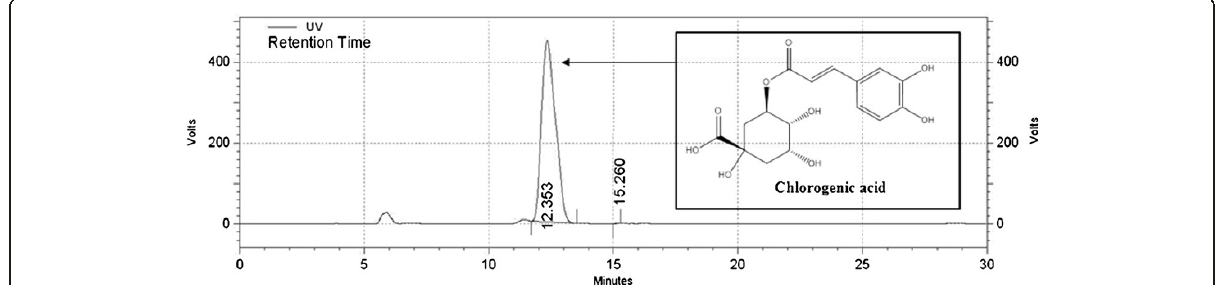
Figure 1 HPLC chromatogram of LJEE (280